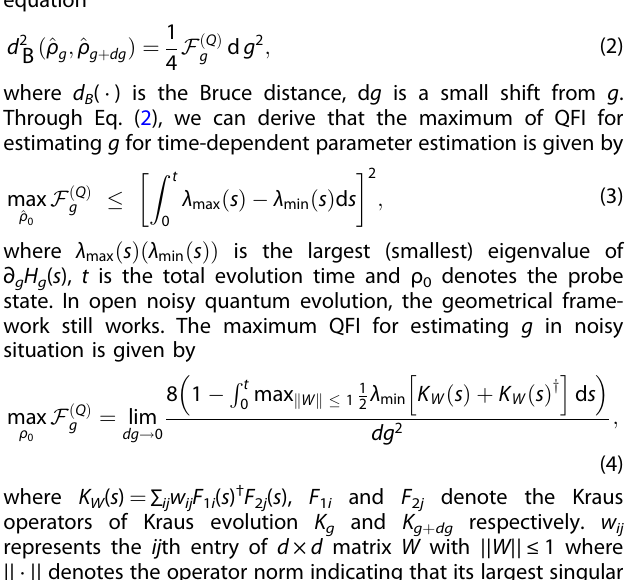
(cid:6) (cid:7) (cid:6)